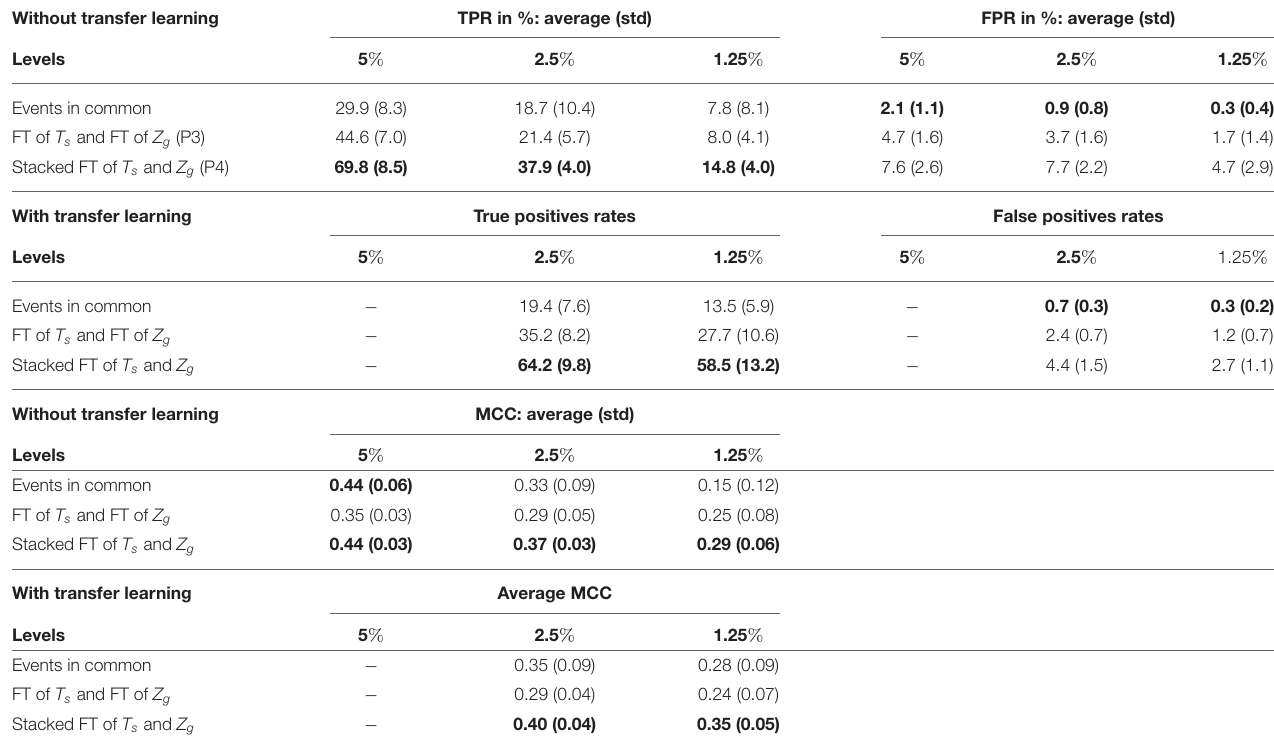
TABLE 2 | Compared performance for heatwave occurrence prediction with different data aggregation protocols. Without transfer